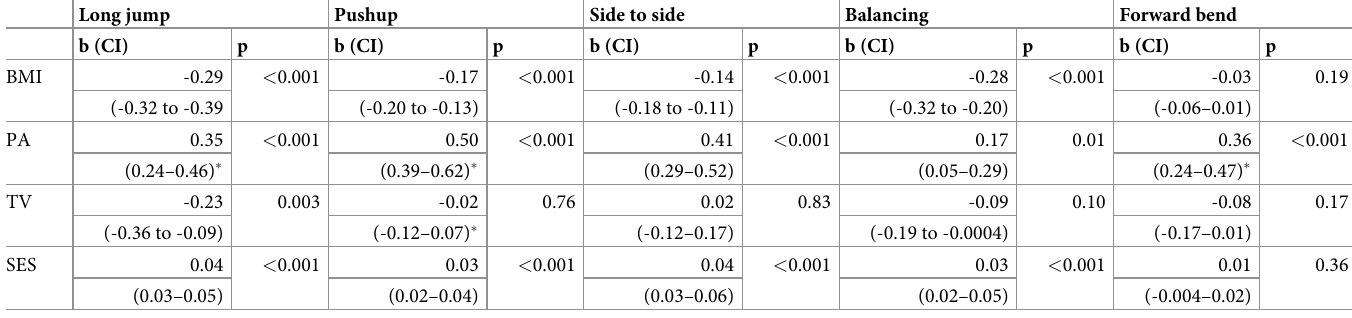
BMI (as continuous measure), PA (high versus low/normal), TV (long versus short/normal), and SES (as continuous measure) were included